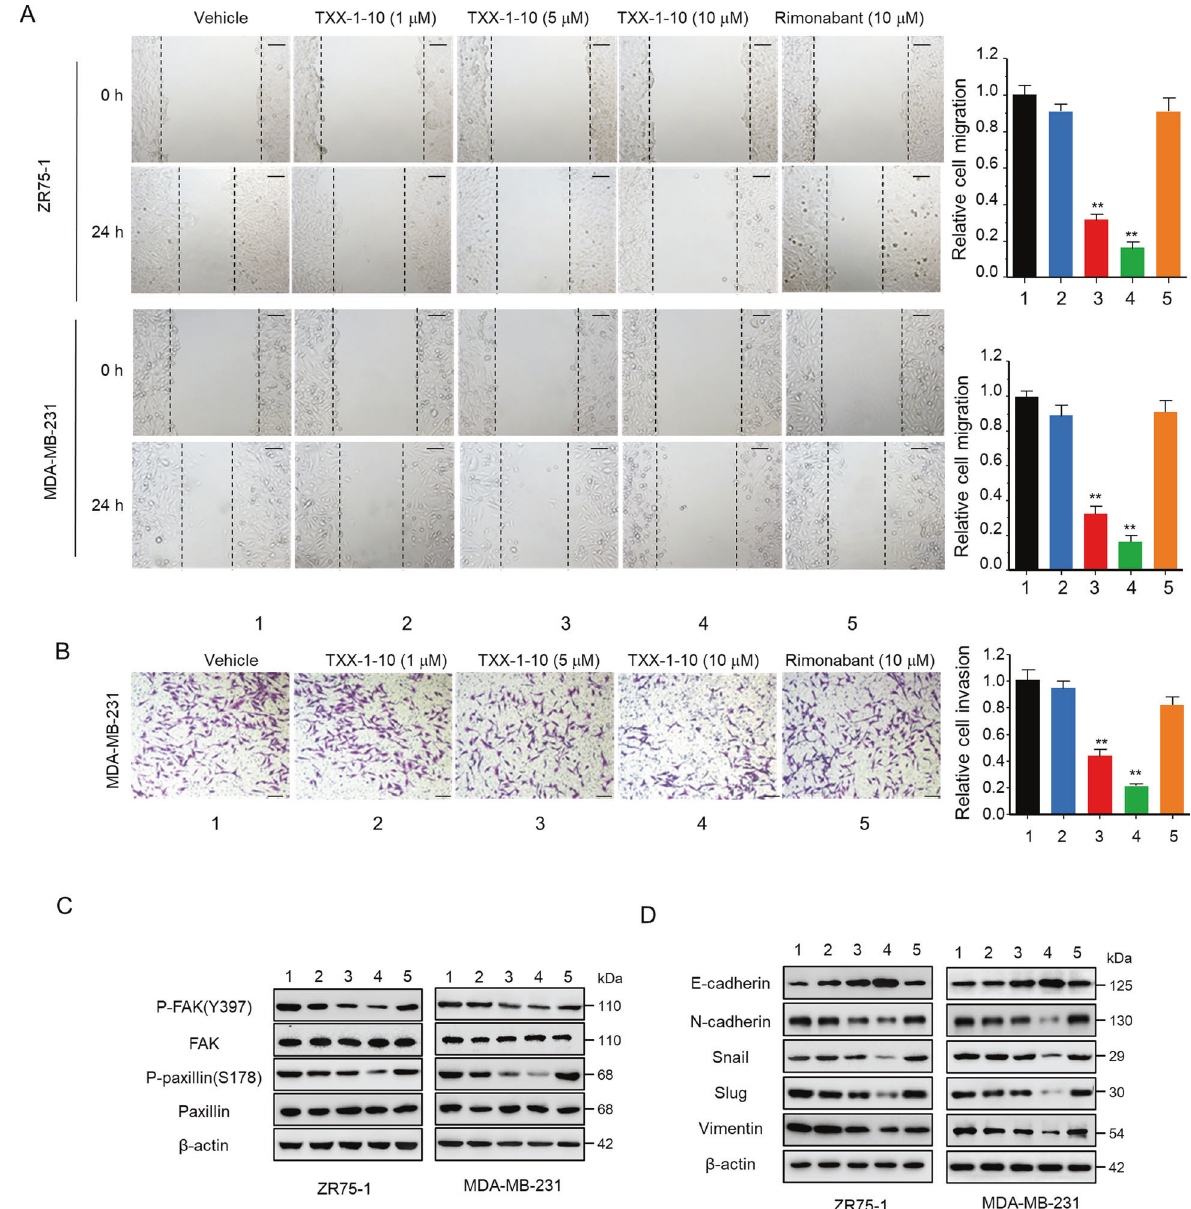
Fig. 4 TXX-1-10 inhibits breast cancer cell migration and invasion. A Wound-healing assay of ZR75-1 and MDA-MB-231 cells treated with TXX-1-10, rimonabant or vehicle control (DMSO) following mitomycin C (1 μ M) treatment at the indicated time. Histograms show the relative cell migration (right panel). Scale bar: 100 μ m. B Transwell assay of MDA-MB-231 cells treated as in A . Invasive cells were fi xed and stained with crystal violet. Histograms show the relative cell invasion (bottom). C Western blot assay of ZR75-1 and MDA-MB-231 cells treated with increasing concentrations of TXX-1-10 for 24 h with the indicated antibodies. D Western blot assay of ZR75-1 and MDA-MB-231 cells treated with increasing concentrations of TXX-1-10 for 24 h with the indicated antibodies. Data shown are mean ± SD of triplicate measurements that have been repeated three times with similar results. Statistical signi fi cance was assessed by two-tailed Student ’ s t test. * p < 0.05, ** p < 0.01 versus the corresponding